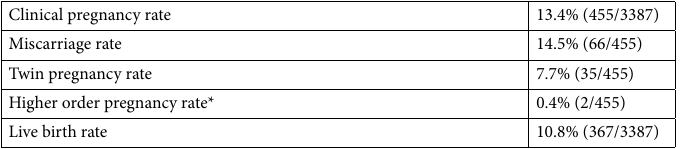
Table 2. Outcomes of COS-IUI cycles performed during the study period. Data are expressed as percentage (n/total). *Defined as the presence of more than two embryos on the ultrasound at 7 weeks GA.